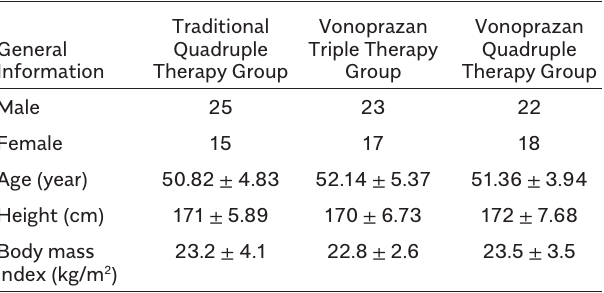
General Information